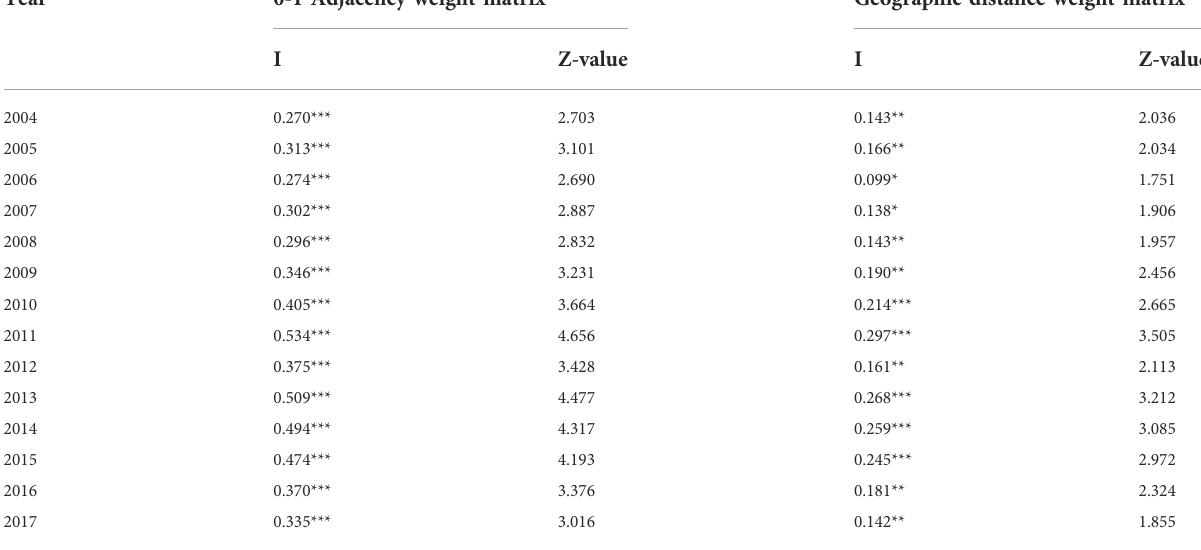
TABLE 6 Global spatial autocorrelation test results of China ’ s Ecological well-being performance levels from 2004 to